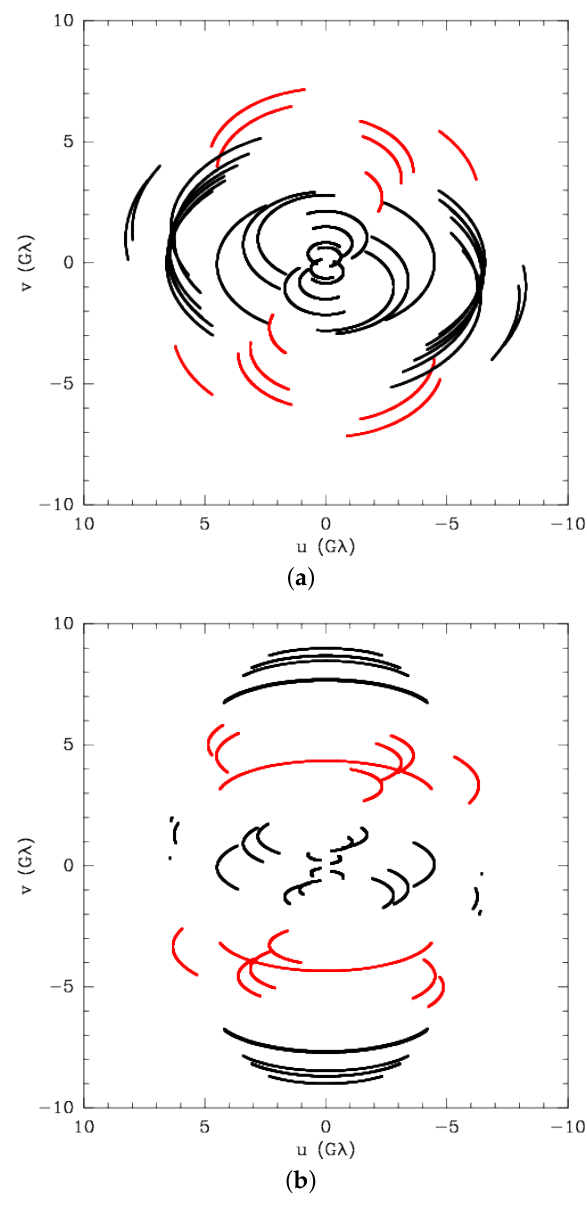
Figure 1. Event Horizon Telescope (EHT) 1.3 mm baseline coverage for a source at + 40 ◦ declination ( a ) and − 20 ◦ ( b ). Baselines to Atacama Large Millimeter/submillimeter Array (ALMA) are shown in red. ALMA baselines extend north-south coverage and are especially important for southern sources, where they fill in a large gap in the ( u , v ) plane between the intra–northern hemisphere baselines and the very long baselines to the South Pole